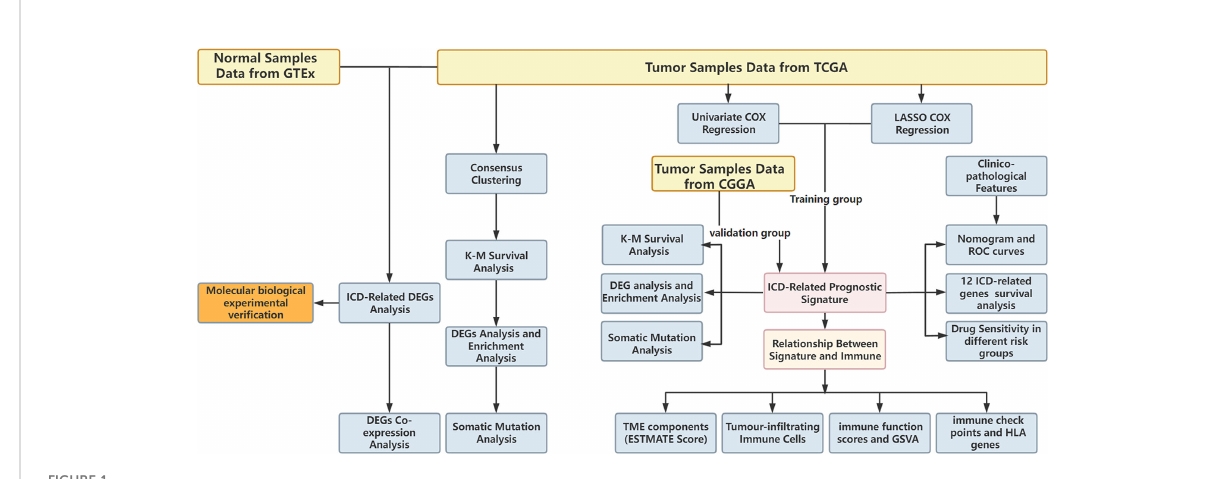
FIGURE 1 The fl ow chart of research